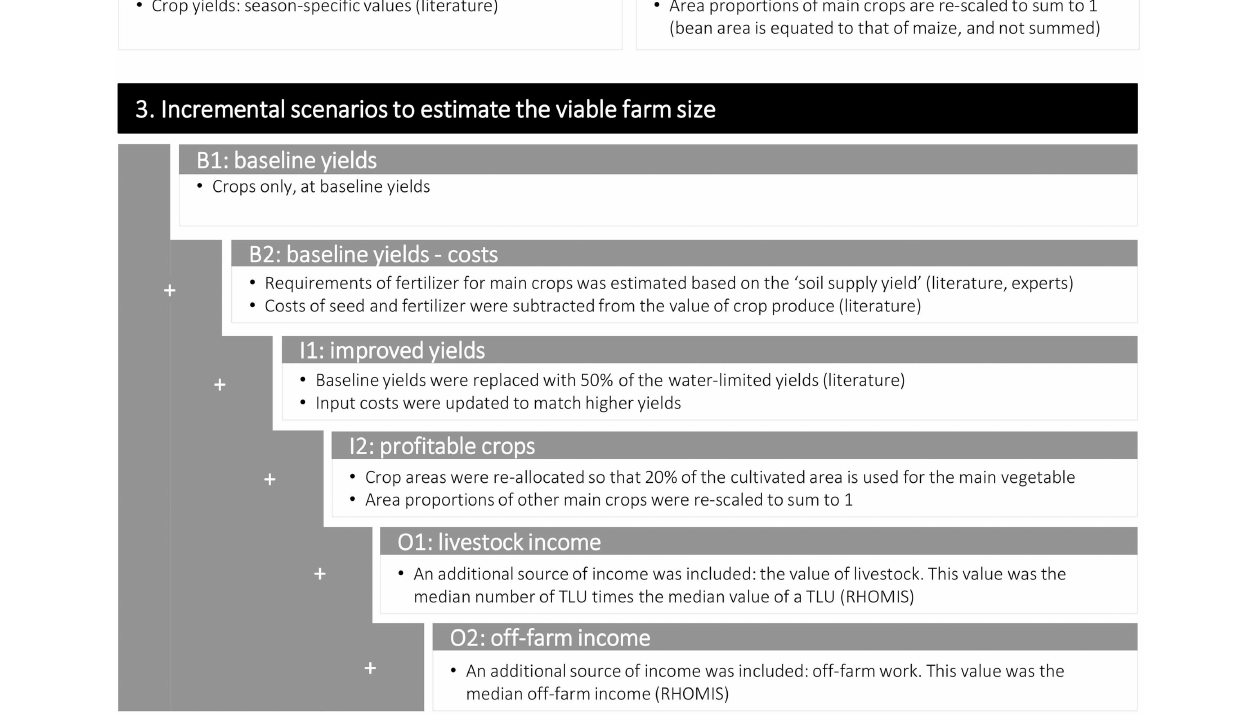
FIGURE 1 | A schematic overview of the scenarios and progression of variables and values with every step in the methodology. TLU, tropical livestock unit; PPP, purchasing power parity (2017).